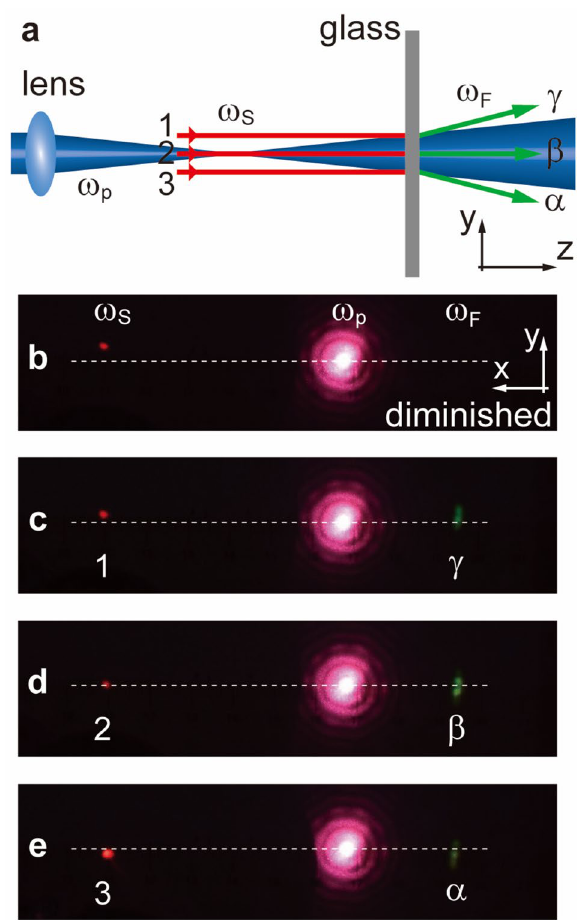
Figure 3. Nonlinear refractions across a defocusing pump. By properly positioning the signal across different diverging regimes of the pump in the flat slab, several nonlinear refraction relations of varying ϕ are shown in ( b – e ). ( a ) Experimental setup: the generation of the FWM beam in the y ~ z plane is predicted to be diverging. ( b – e ) Images on the target screen ( x–y plane) in the far field. Leftmost red spots: signal 1300 nm, centered red: pump 800 nm, rightmost green spots: FWM beam 578 nm. The horizontal dashed lines serve as references. The FWM spot is downshifted ( γ to α ) when moving the signal spot downwards from 1 to 3 . However, due to the limited phase-matching range, the FWM disappears in ( b